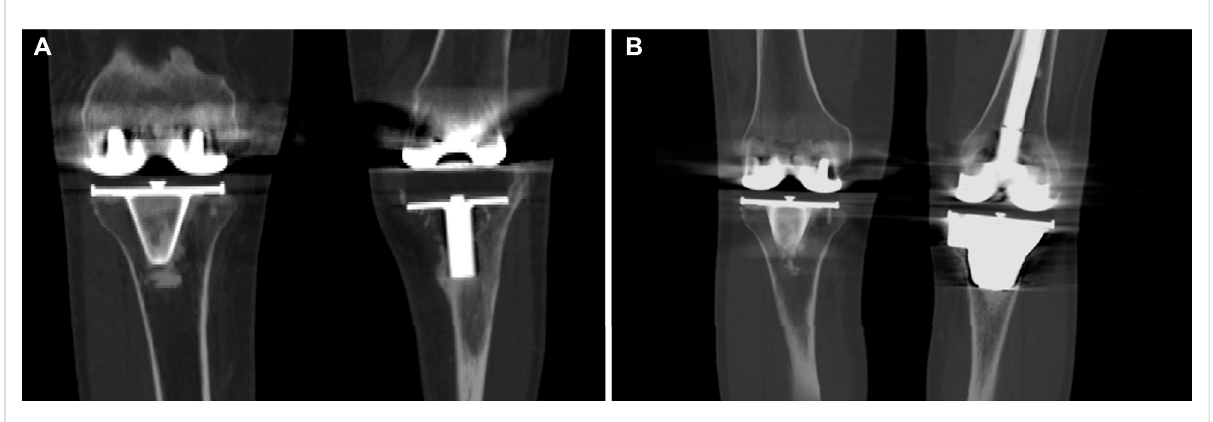
FIGURE 6 CT images of the representative case showed that the tibial bone defect was effectively reconstructed by the porous tantalum cone. (A) Preoperative image; (B) postoperative image at 3 years after the operation.